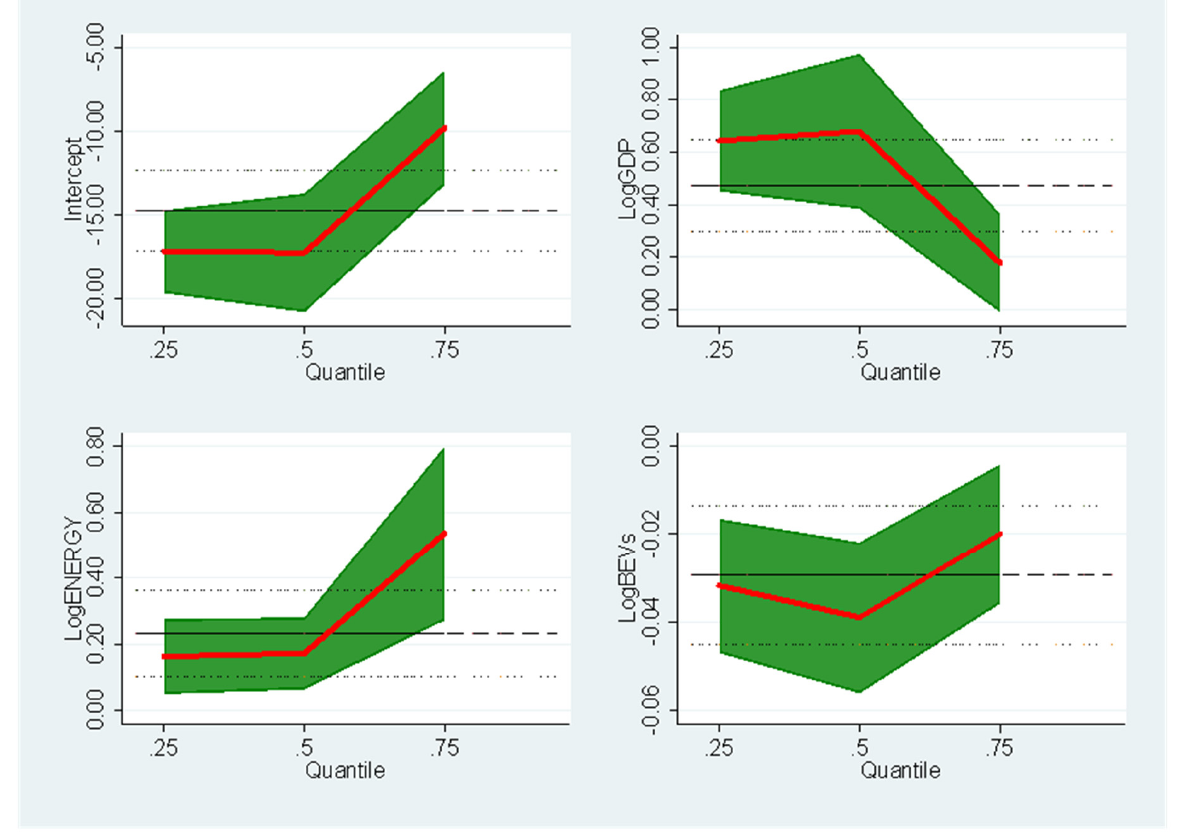
Figure 6. Quantile estimates. Table 11. Estimation results from simultaneous quantile regression and OLS with fixed